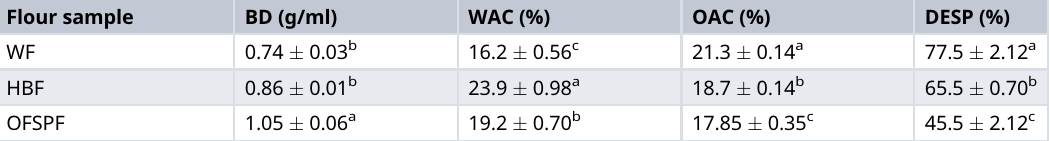
Table 2. Functional properties of OFSP, wheat, and haricot bean flours. Flour